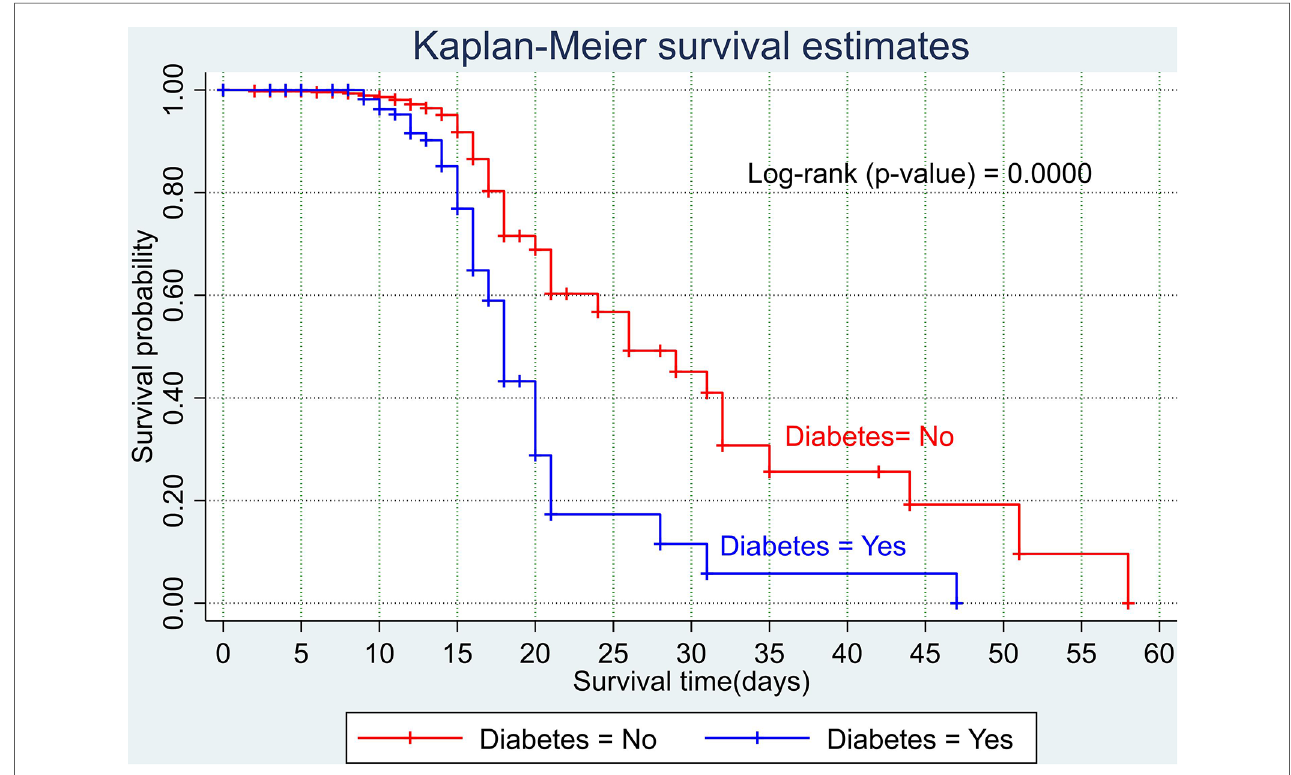
FIGURE 7 Kaplan – Meier survival curve based on the presence of diabetes among adult COVID-19